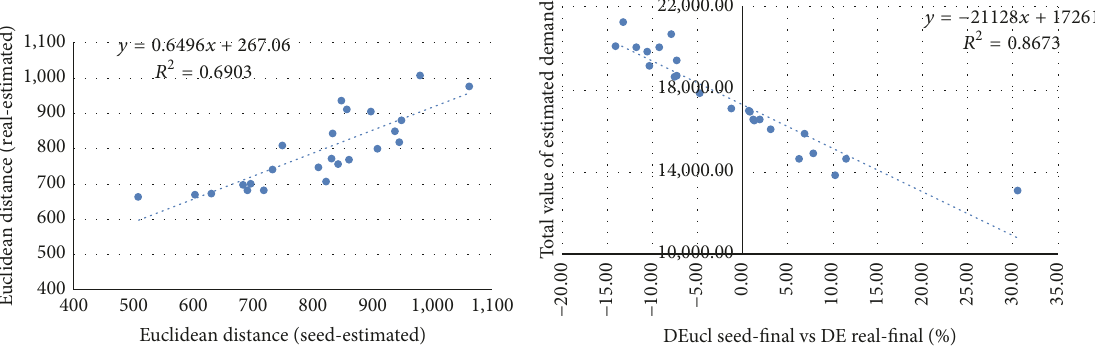
Figure 8: Correlation founded when using DUE, SO, and their combination.